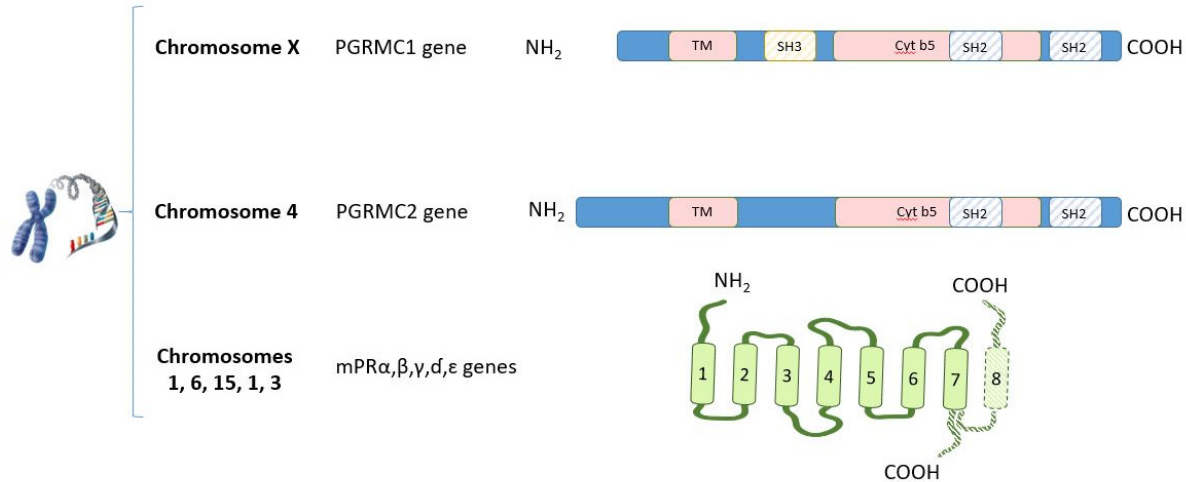
Figure 3. Schematic representation of the non-classical PGR genes and their localization in chromosomes. PGRMC1 and